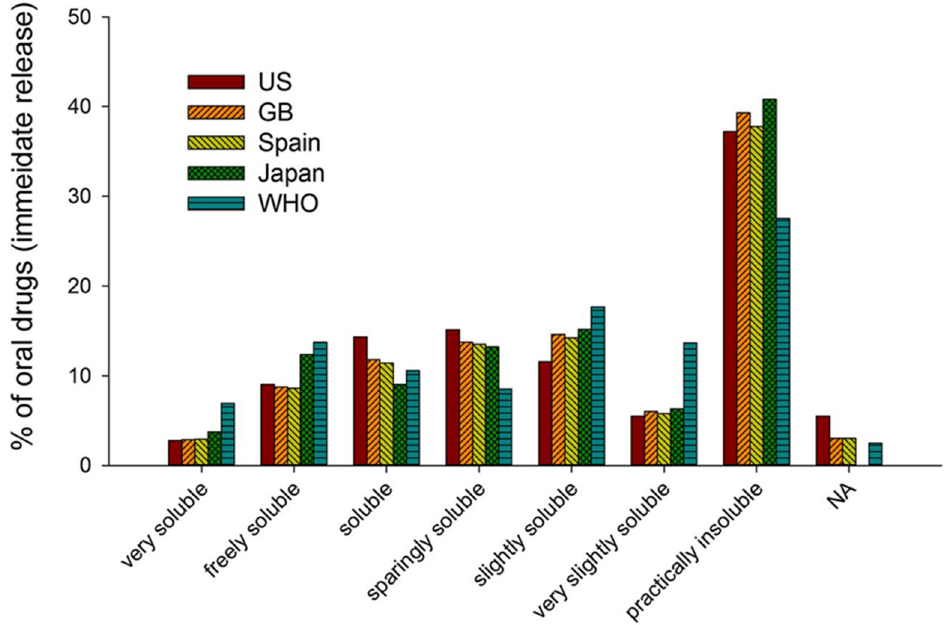
Figure 1. A comparison of the distribution of solubilities for 200 oral drugs from various regions of the world (very soluble drugs: over 1000 mg/mL; freely soluble drugs: 100–1000 mg/mL; soluble drugs: 33–100 mg/mL; sparingly soluble drugs: 10–33 mg/mL; slightly soluble drugs: 1–10 mg/mL; very slightly soluble drugs: 0.1–1 mg/mL; practically insoluble drugs: <0.1 mg/mL). Reproduced with permission from [4] T. Takagi et al, Molecular Pharmaceutics, published by American Chemical Society, 2006.